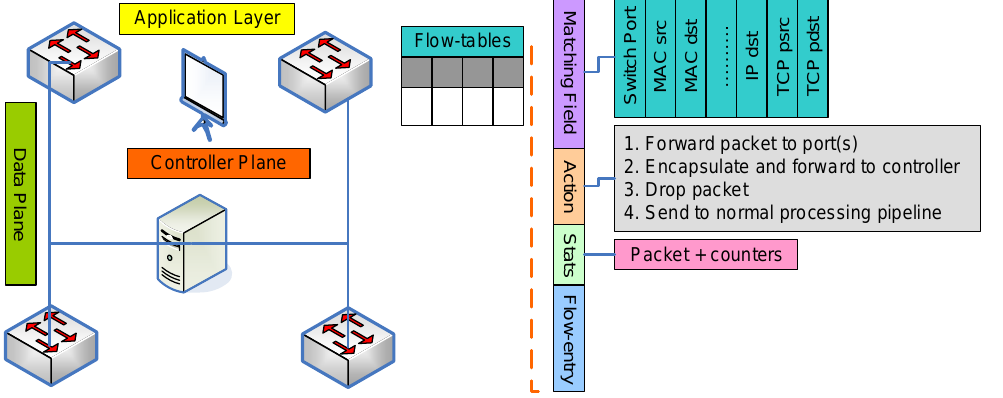
Figure 1. Flow-table and flow-entry structure.